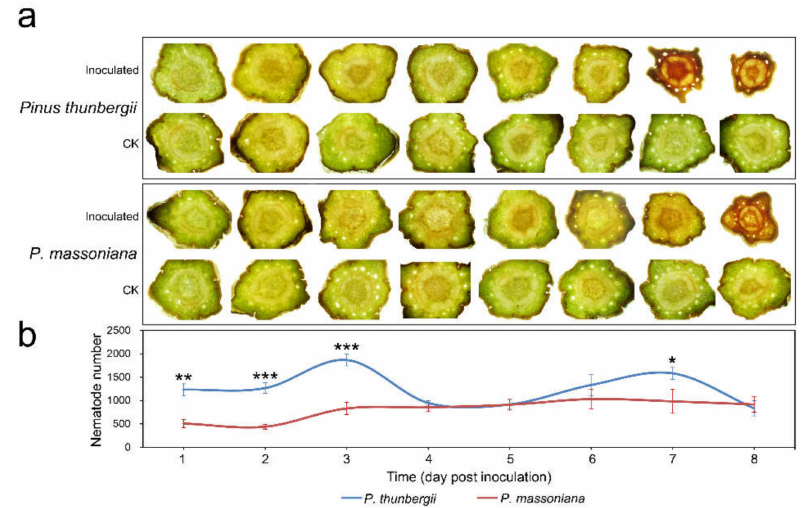
Figure 2. Plant tissue section observation and changes in nematode populations after PWN inocula- tion. ( a ) Changes in segments 1 cm below inoculation sites; ( b ) changes in nematode populations. Error bars indicate the standard deviation (*** p value < 0.001; ** p value < 0.01; * p value < 0.05; P. thunbergii test P. massoniana